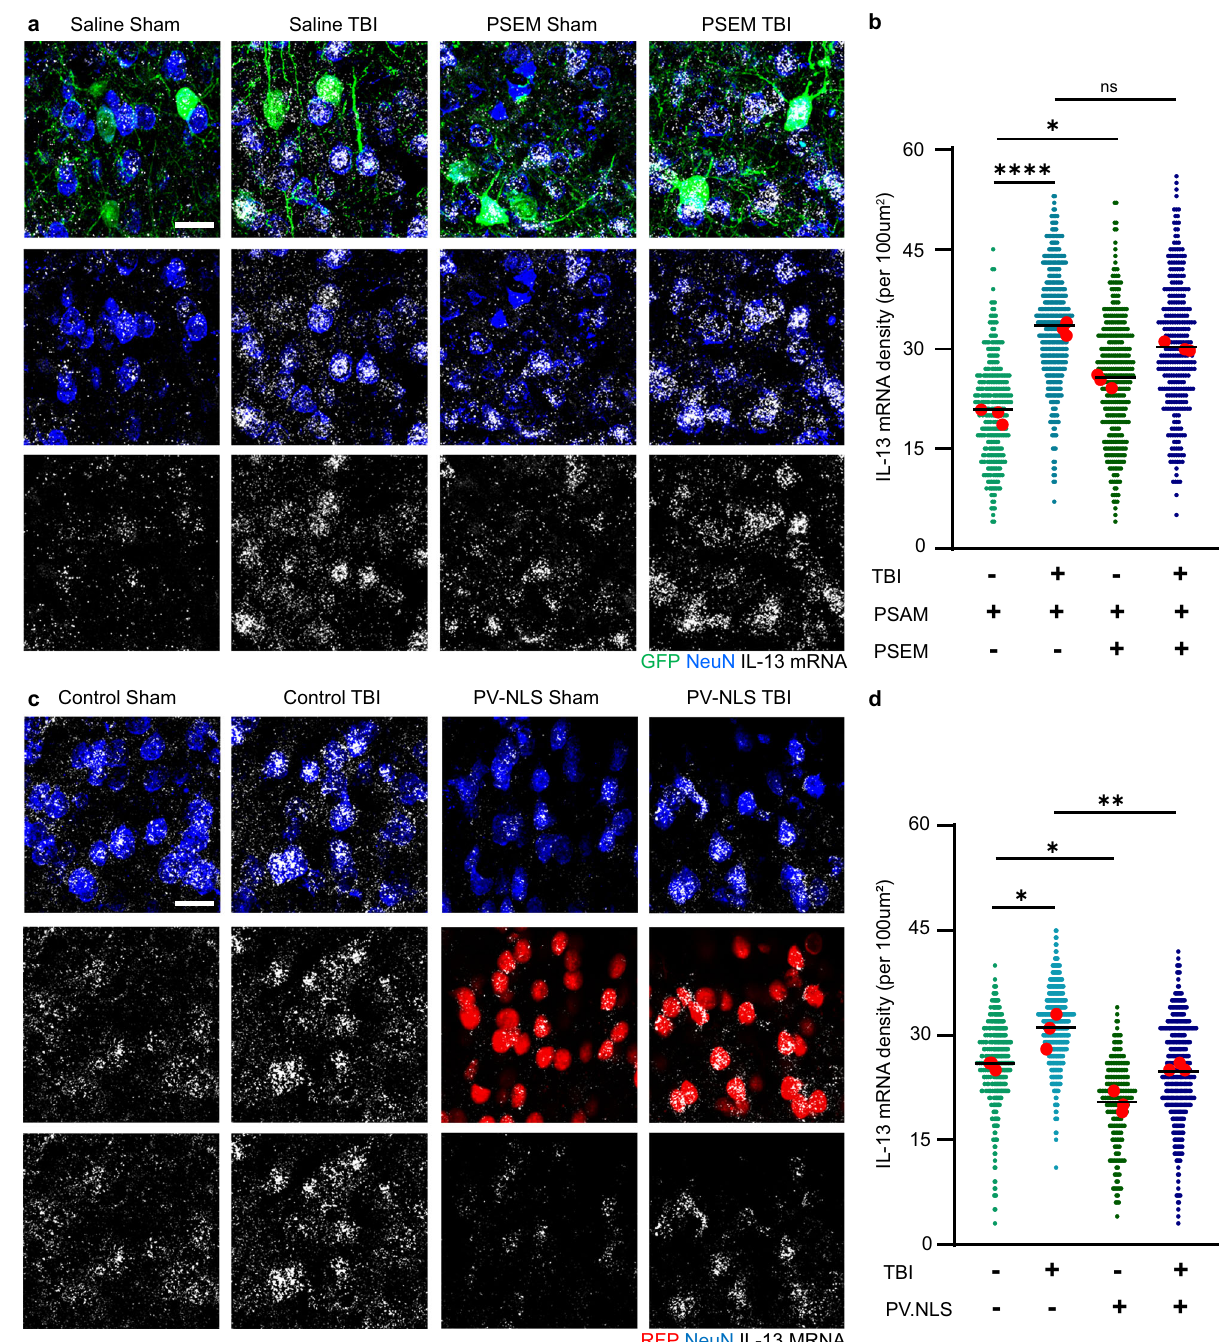
Fig.7|Upregulationofneuronal IL-13 isdrivenbyneuronalactivityandnuclear calcium signaling upon traumatic brain injury. a , b Upregulation of IL-13 mRNA expression upon blunt, closed TBI in mouse (3h post injury). Chemogenetic sup- pressionof inhibitoryPVinterneuronsenhancesthe upregulationof IL-13 mRNAat baseline and after trauma (Saline Sham vs Saline TBI: p <0.0001; Saline Sham vs PSEM Sham: p =0.0150; Saline TBI vs PSEM TBI: p =0.0742). N =3; n =SS: 332; ST: